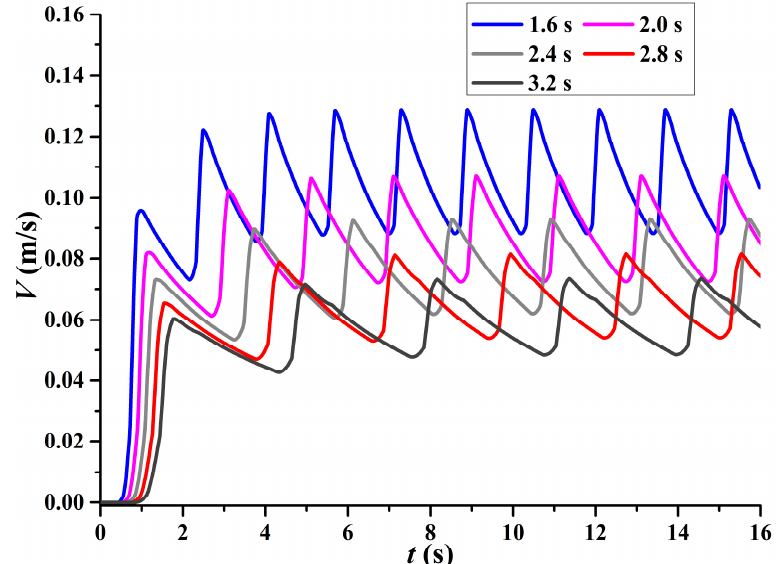
Figure 13. The speeds of the robot as a function of time t in different stroke cycles T . The blue, pink gray, red, and black lines are the speeds of the robot when the stroke cycles are 1.6, 2, 2.4, 2.8 and 3.2 s, respectively.